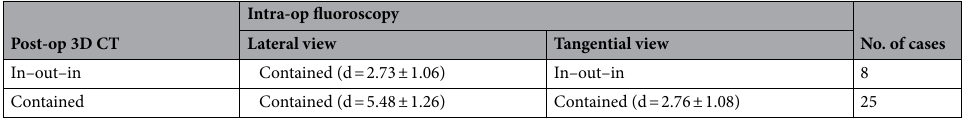
Table 1. Evaluation of the posterosuperior femoral neck screw position based on intra-operative fluoroscopy and post-operative CT.